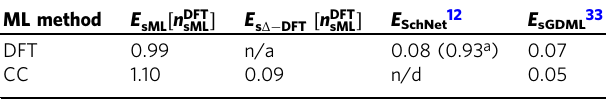
Table 1 MAEs (kcal mol − 1 ) of sML ethanol maps compared to other ML models using forces and energies.